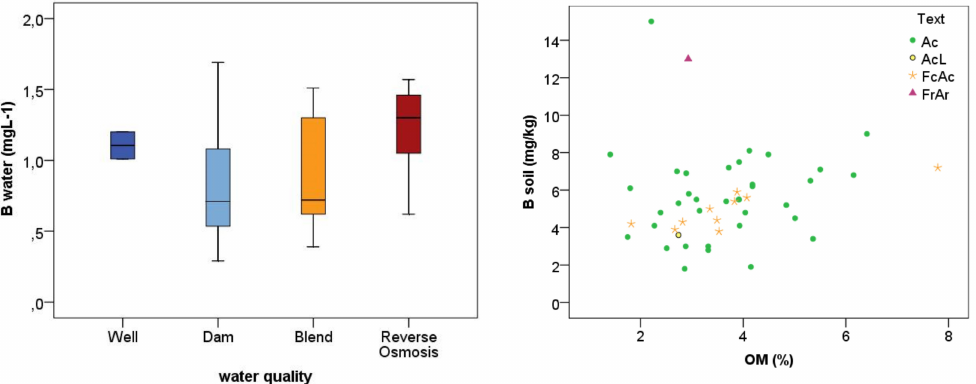
Figure 1. a (left) B concentration (mg / L) of the four water origins from 2018 and b (right) B in soil, data distribution of B soils determined in hot water (HWSB) (mg / kg) related to organic matter (OM) content (in